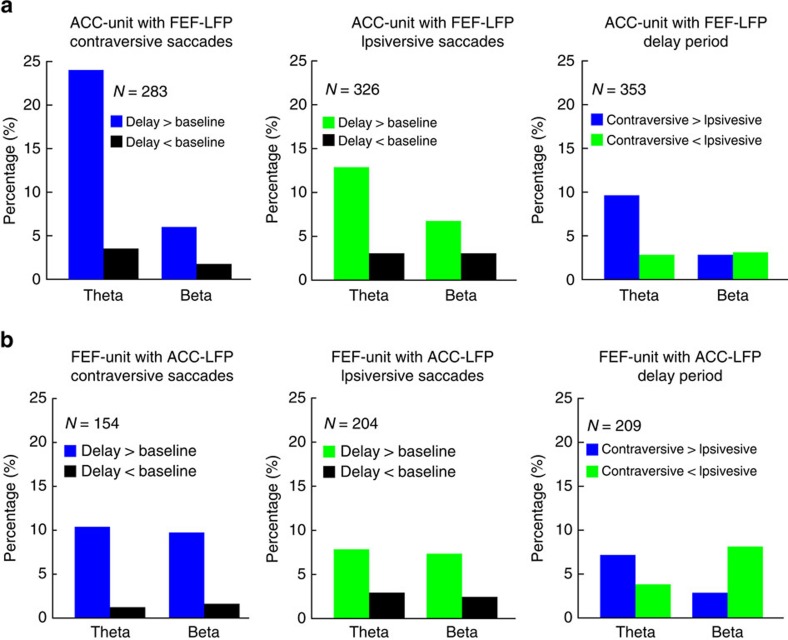
Percentage of units with significant spike-field coupling in theta and beta band.(a) Percentage of the ACC-unit with FEF-LFP pairs showing significant changes in phase locking across the theta and beta frequency range. Comparison between baseline and delay of contraversive saccades (left), comparison between baseline and delay of ipsiversive saccades (middle), and comparison between the contra- and ipsiversive saccades in the delay period (right). (b) Same as in a, but now depicted the percentage of the FEF-unit with ACC-LFP pairs showing significant changes in phase locking across the theta and beta frequency range. Statistical testing was performed using two-sided permutation tests, such that chance level is 2.5%.